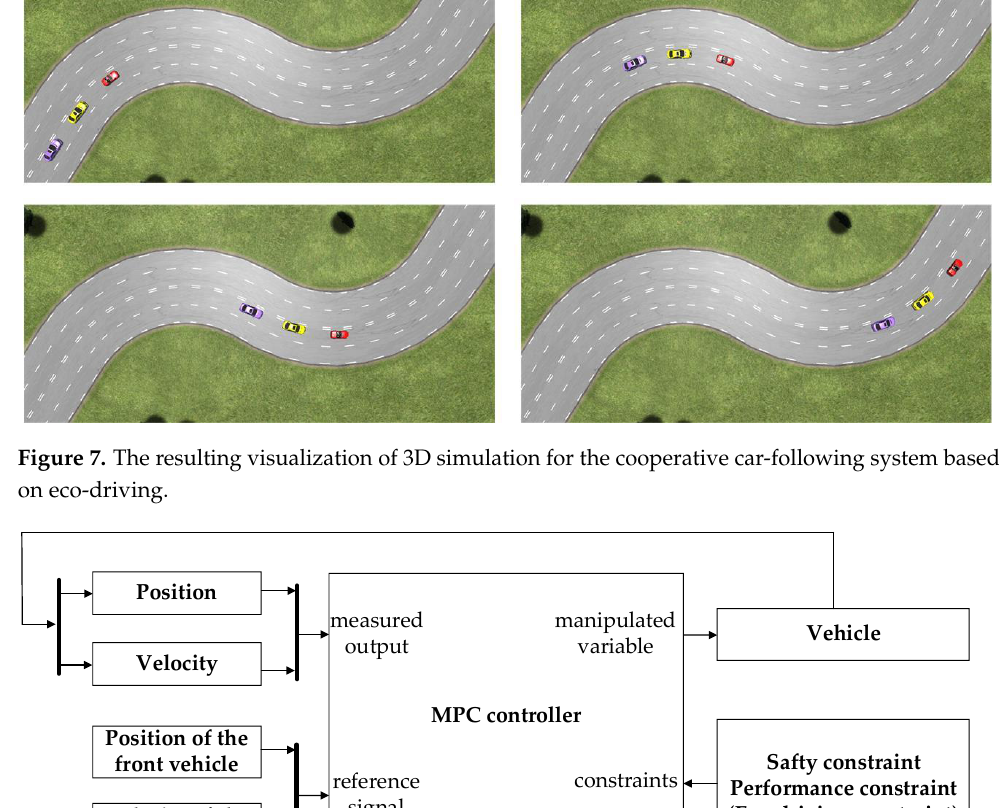
Figure 7. The resulting visualization of 3D simulation for the cooperative car-following system based on eco-driving.